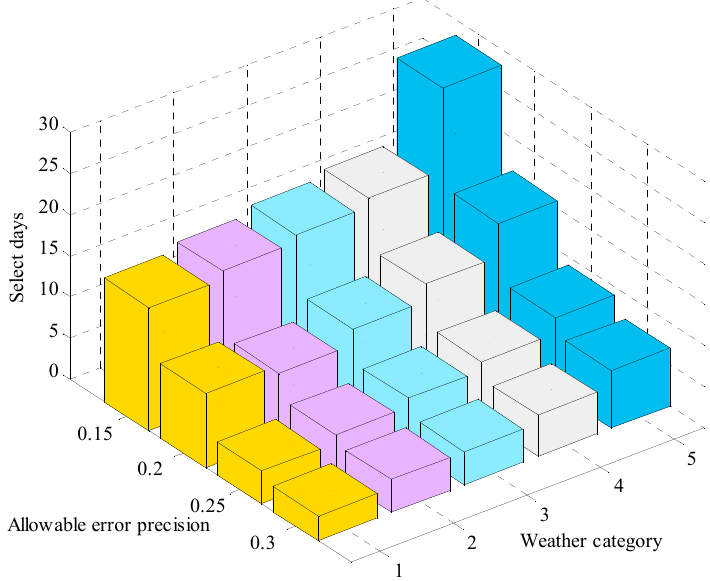
Figure 5. Optimal sample capacity estimation.